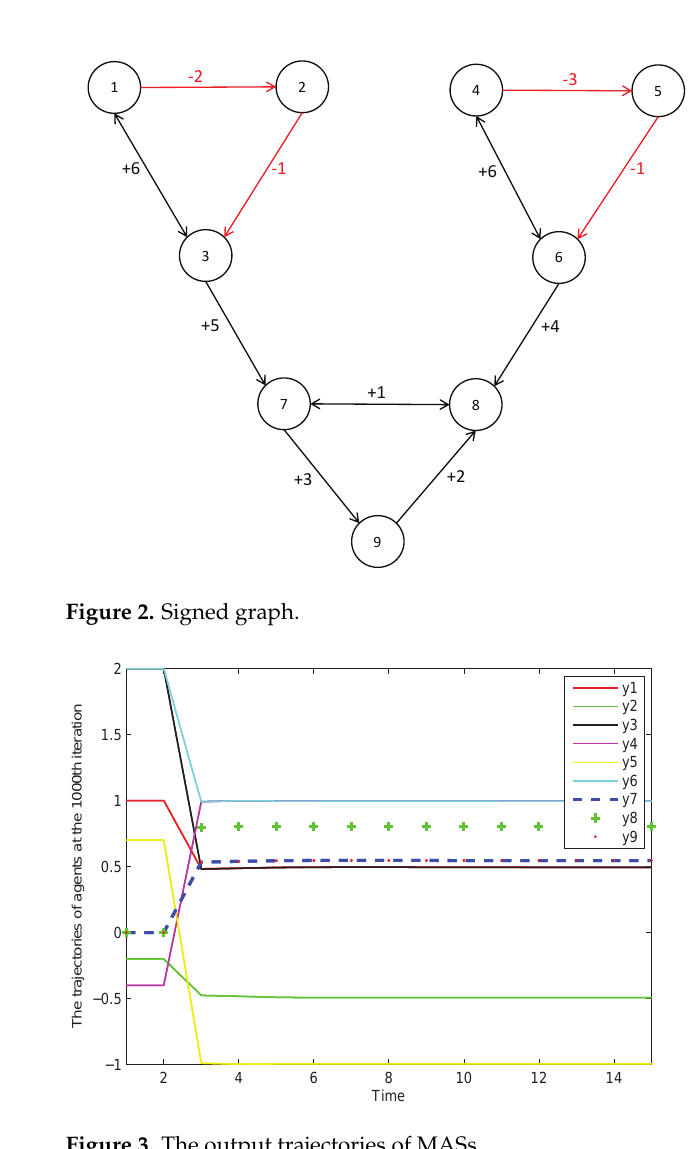
Figure 3. The output trajectories of MASs.